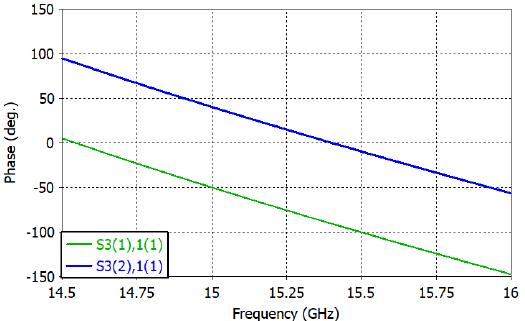
Figure 4. Transmission phase of the designed polarizer excited with a coaxial probe.